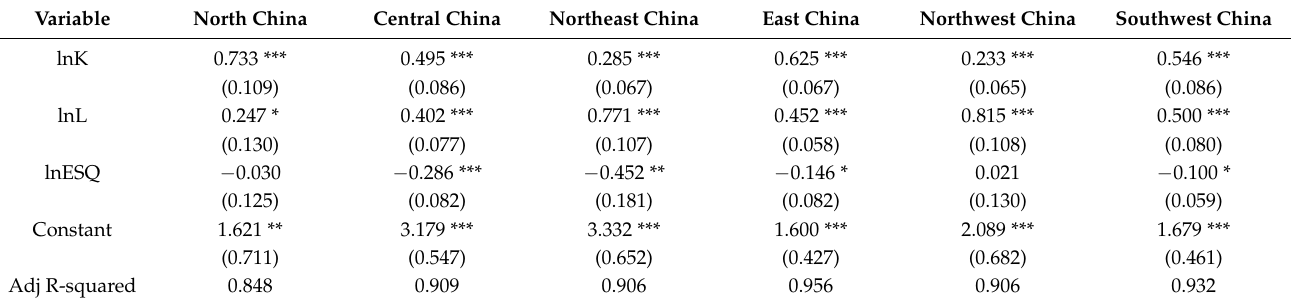
Table 4. Regression results among different regions.